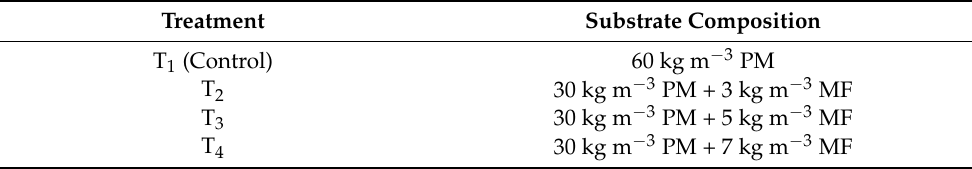
Table 1. Details of four investigated treatments with their respective substrate compositions.